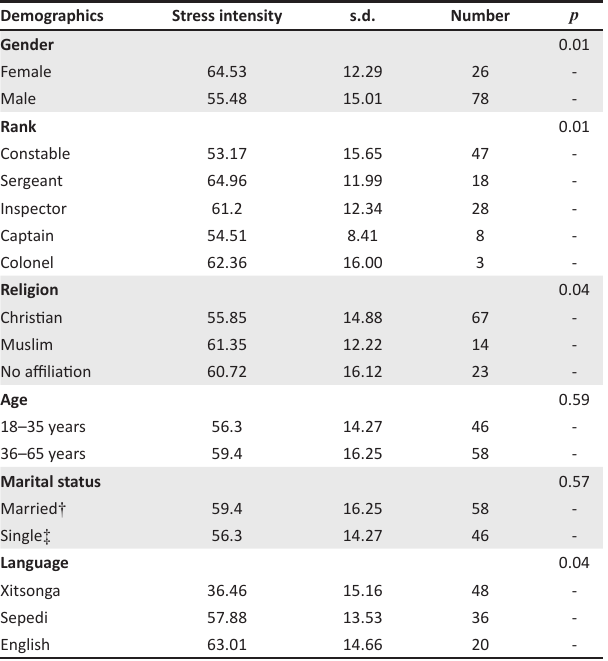
TABLE 3: Demographic data and stress intensity scores. Demographics Stress